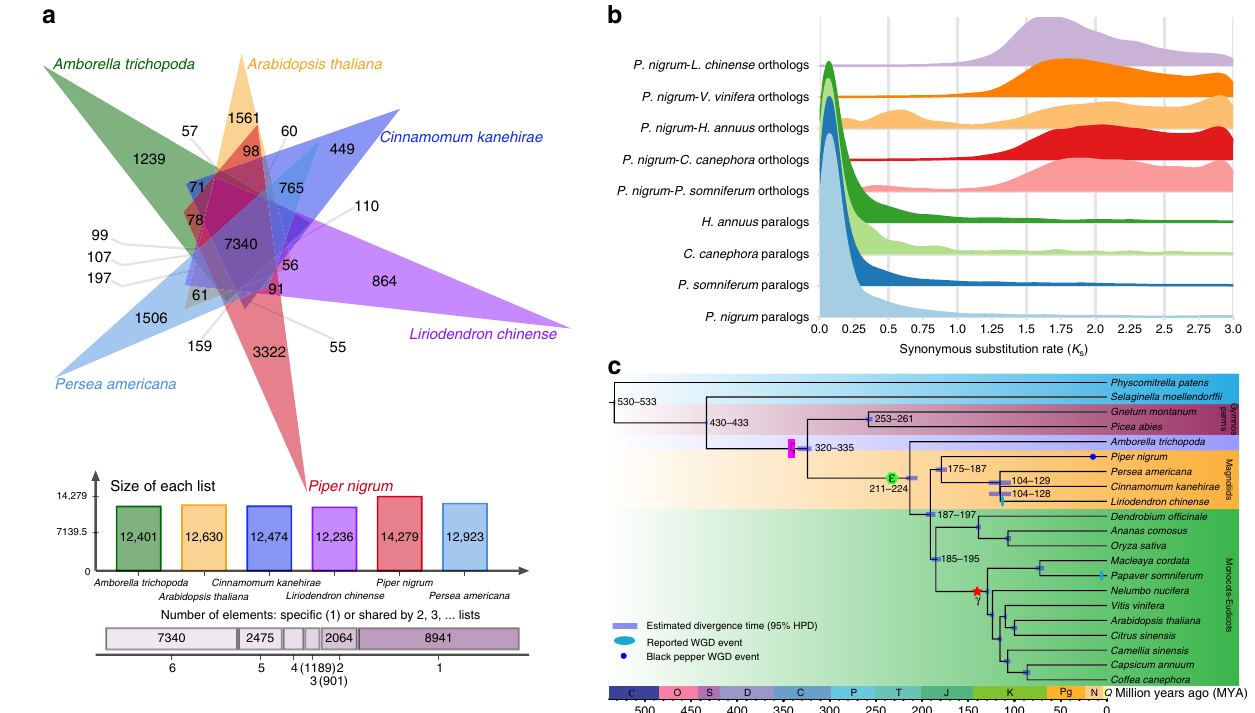
Fig. 2 Comparative genomic analysis of black pepper and WGD. a Sharing of gene families by black pepper and fi ve other species. The numbers indicate gene families identi fi ed among all selected species. b Synonymous substitution rate ( K s ) distributions of syntenic blocks for Piper nigrum paralogs and orthologs with other eudicots are shown by coloured lines, as indicated. c Phylogenetic tree with 82 single-copy orthologs from 21 species identi fi ed by OrthoMCL to show divergence times. Piper nigrum was placed sister to Magnoliales – Laurales among the magnoliids. Posterior probabilities for all branches exceed 0.99. Divergence times were estimated using BEAST and are indicated by light blue bars at the internodes with 95% highest posterior density (HPD). Є Cambrian, O Ordovician, S Silurian, D Devonian, C Carboniferous, P Permian, T Triassic, J Jurassic, K Cretaceous, Pg Paleogene, N Neogene. The source data underlying Fig. 2a and b are provided as a Source Data fi